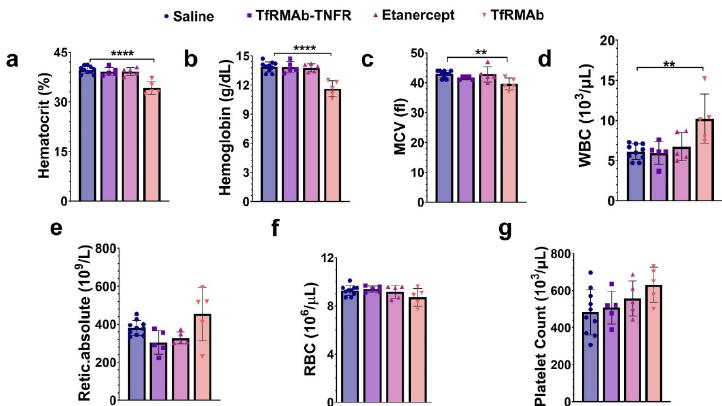
Figure 7. Effect of TfRMAb-TNFR on BBB tight-junction proteins and brain inflammation. Chronic TfRMAb-TNFR dosing in aged APP/PS1 mice significantly increased ZO-1 ( a ) and claudin-5 ( b ) compared to the saline-treated mice measured using Western blotting of the cerebrum homogenates. Both TfRMAb-TNFR and etanercept increased I ĸ Bα in the cerebrum homogenates compared to the saline-treated mice ( c ). Data are presented as mean ± SD of n = 4–9 per treatment group, and data were analyzed using the one-way ANOVA with the Holm Sidak’s post hoc test. * p < 0.05 and ** p < 0.01 for the indicated comparisons.